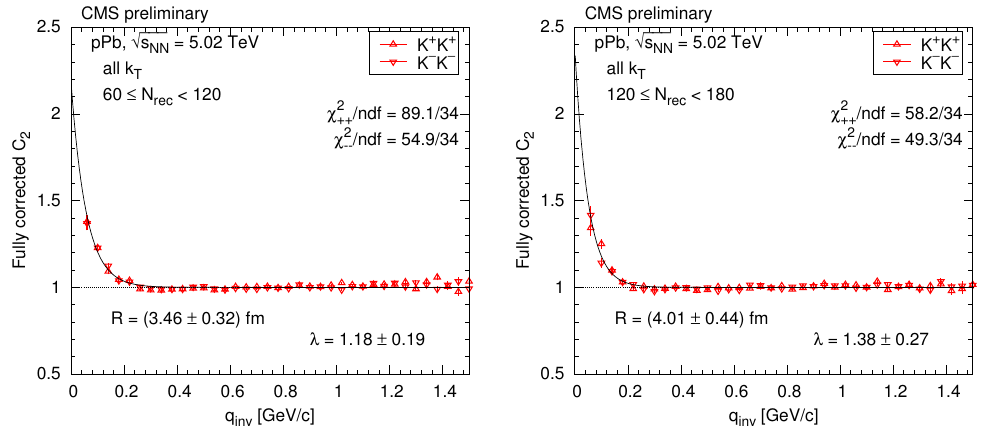
Figure 4. The like-sign correlation function of kaons (red triangles) corrected for Coulomb interaction and cluster contribution (mini-jets and multi-body resonance decays) as a function of q inv , in some selected N rec bins for all k T [8]. Points with statistical uncertainty higher than 10% are plotted with light grey color. The solid curves indicate fits with the Bose–Einstein parametrization.